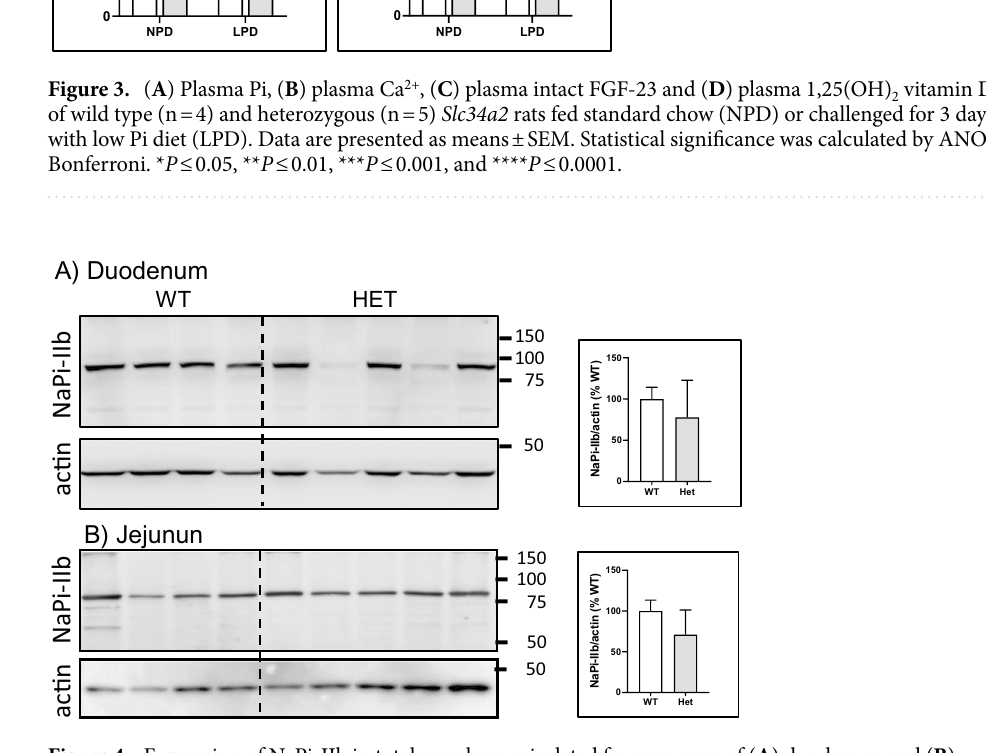
Figure 4. Expression of NaPi-IIb in total membranes isolated from mucosa of ( A ) duodenum and ( B ) jejunum from wild type (n = 4) and heterozygous (n = 5) Slc34a2 rats challenged for 3 days with low Pi diet. The abundance of the cotransporter was normalize to the expression of actin. The ratio in WT rats was considered as